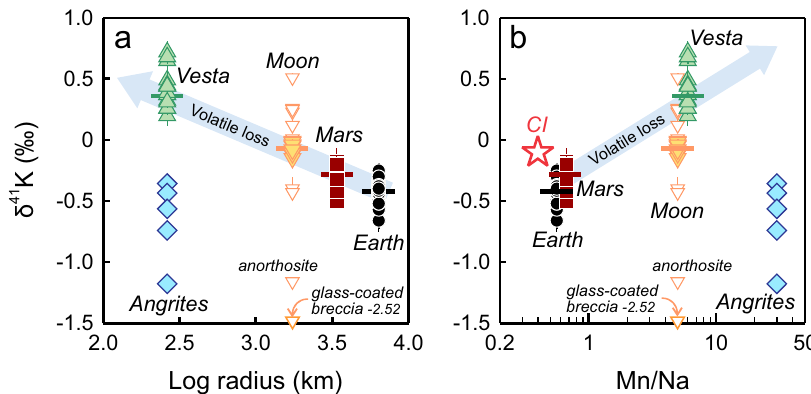
Fig. 2 | Angrites deviate from the trend of increasing δ 41 K with enhanced volatiledepletionde fi nedbyotherplanetarybasalts. The blue arrows illustrate the direction of increasing volatile loss indicated by a smaller planetary size and b elevated Mn/Na ratio. The δ 41 K values of differentiated terrestrial bodies are from the literature, including Earth (refs. 24, 25, 66), Mars (refs. 12, 27, 34), the Moon (refs. 11, 33), and Vesta (refs. 27, 34). The Mn/Na ratios of CI chondrites,